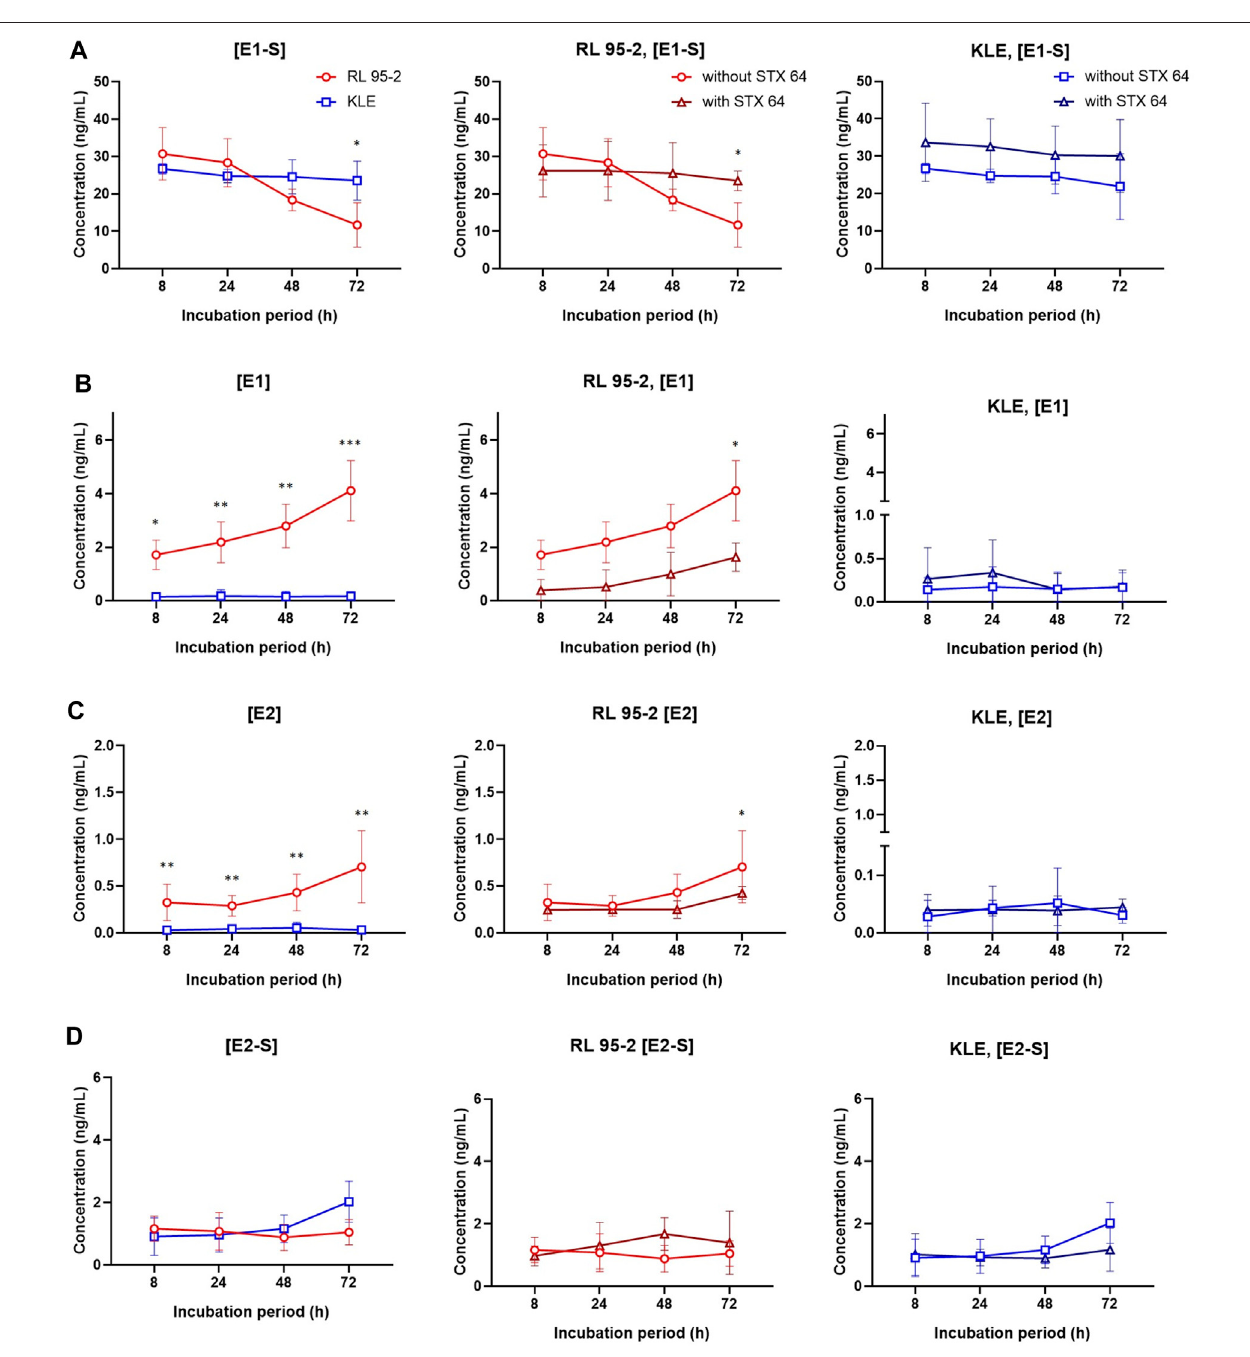
FIGURE 6 | E1-S metabolism in RL95-2 and KLE cells. Time courses for the estrogen metabolites following addition of 2.3 nM E1-S to the cells, for E1-S (A) , E1 (B) ,E2 (C) ,andE2-S (D) ,inthepresenceandabsenceof10 nMSTX64(sulfataseinhibitor).Dataaremeans ± SD.*, p < 0.05;**, p < 0.01;***, p < 0.001(ANOVAplus Tukey ’ s